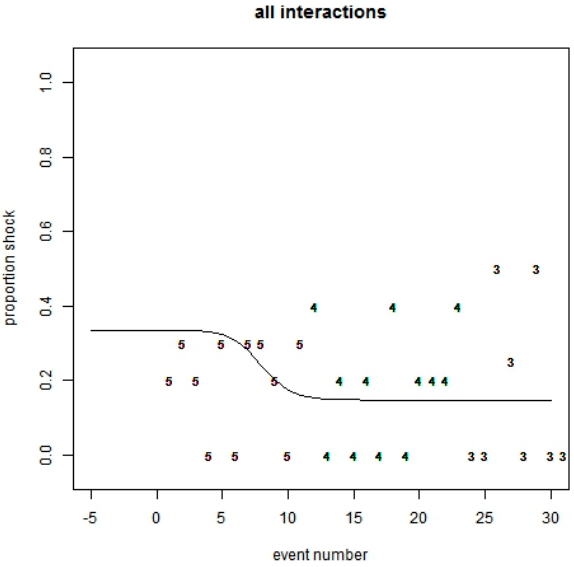
Figure 2. Logistic curve for the associative learning trial for six sheep. Y-Axis is the proportion of animals that receive a stimulus following an audio cue. X-Axis is number of interactions with the virtual fence throughout the entire testing period. The numerals are the number of animals that approached the exclusion zone for that event number.